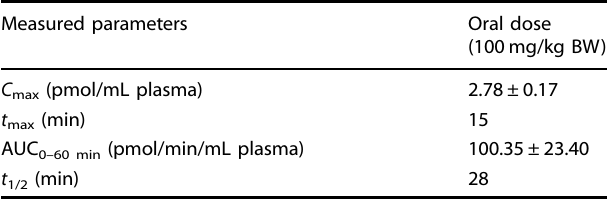
Data are expressed as means ±SEM ( n = 5).